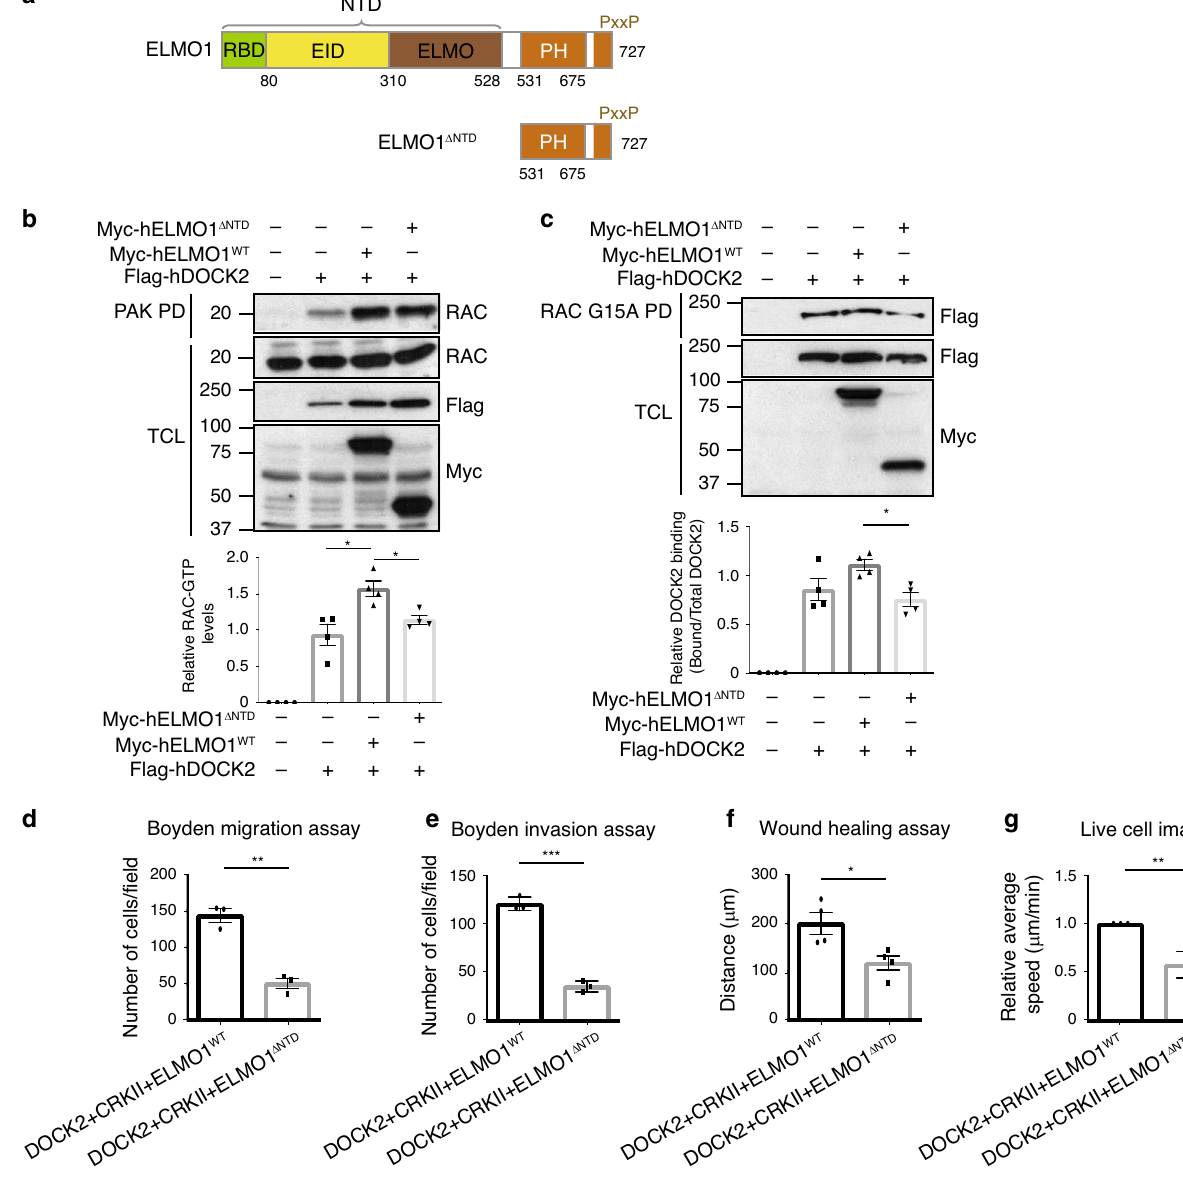
Fig. 8 ELMO1 NTD is required for RAC1 signalling mediated by DOCK2. a Schematic of full length ELMO1 and ELMO1 Δ NTD domains. b Expression of ELMO1 Δ NTD leads to less RAC1 activation when compared with ELMO1 WT expression. 293 T cells transfected with the indicated plasmids were subjected to a RAC activation assay (GST-PAK1 PBD pulldown). RAC activation levels were detected by western blotting and quanti fi ed using ImageJ. c DOCK2 WT binds less nucleotide-free RAC1 upon expression of ELMO1 Δ NTD . Lysates of 293 T cells expressing the indicated plasmids were used for GST-Rac1 G15A pulldown. Levels of Flag-DOCK2 bound to RAC1 were detected by western blotting and quanti fi ed by ImageJ. The experiments in ( b ) and ( c ) were performed four times. d , e Boyden migration ( d ) and invasion ( e ) assay performed with HeLa cells transfected with the indicated plasmids. Number of cells migrated were counted via DAPI staining of the membrane. ( n = 3, 10 fi elds used at 10X per condition per experiment). f Quanti fi cations of transfected HeLa cells displacement in a wound healing assay. Experiments were performed four times, imaging four fi elds using a 10X objective per condition. g Average speed of transfected HeLa cells time-lapse imaged for 6 h. Average speed was quanti fi ed using manual tracking on ImageJ. Experiments were performed four times, imaging four fi elds using a 10X objective per condition. Data were analysed from three experiments and expressed as mean ± s. e.m. Two-tailed unpaired student ’ s t -test was used ( d , e , f , g ) and Mann – Whitney test ( b , c ). (* p = 0.0286 ( b , c ); ** p = 0.0014 ( d ); *** p = 0.000089 ( e ); * p = 0.0216 ( f ); ** p = 0.0058 ( g )). Source data are provided as a Source Data fi